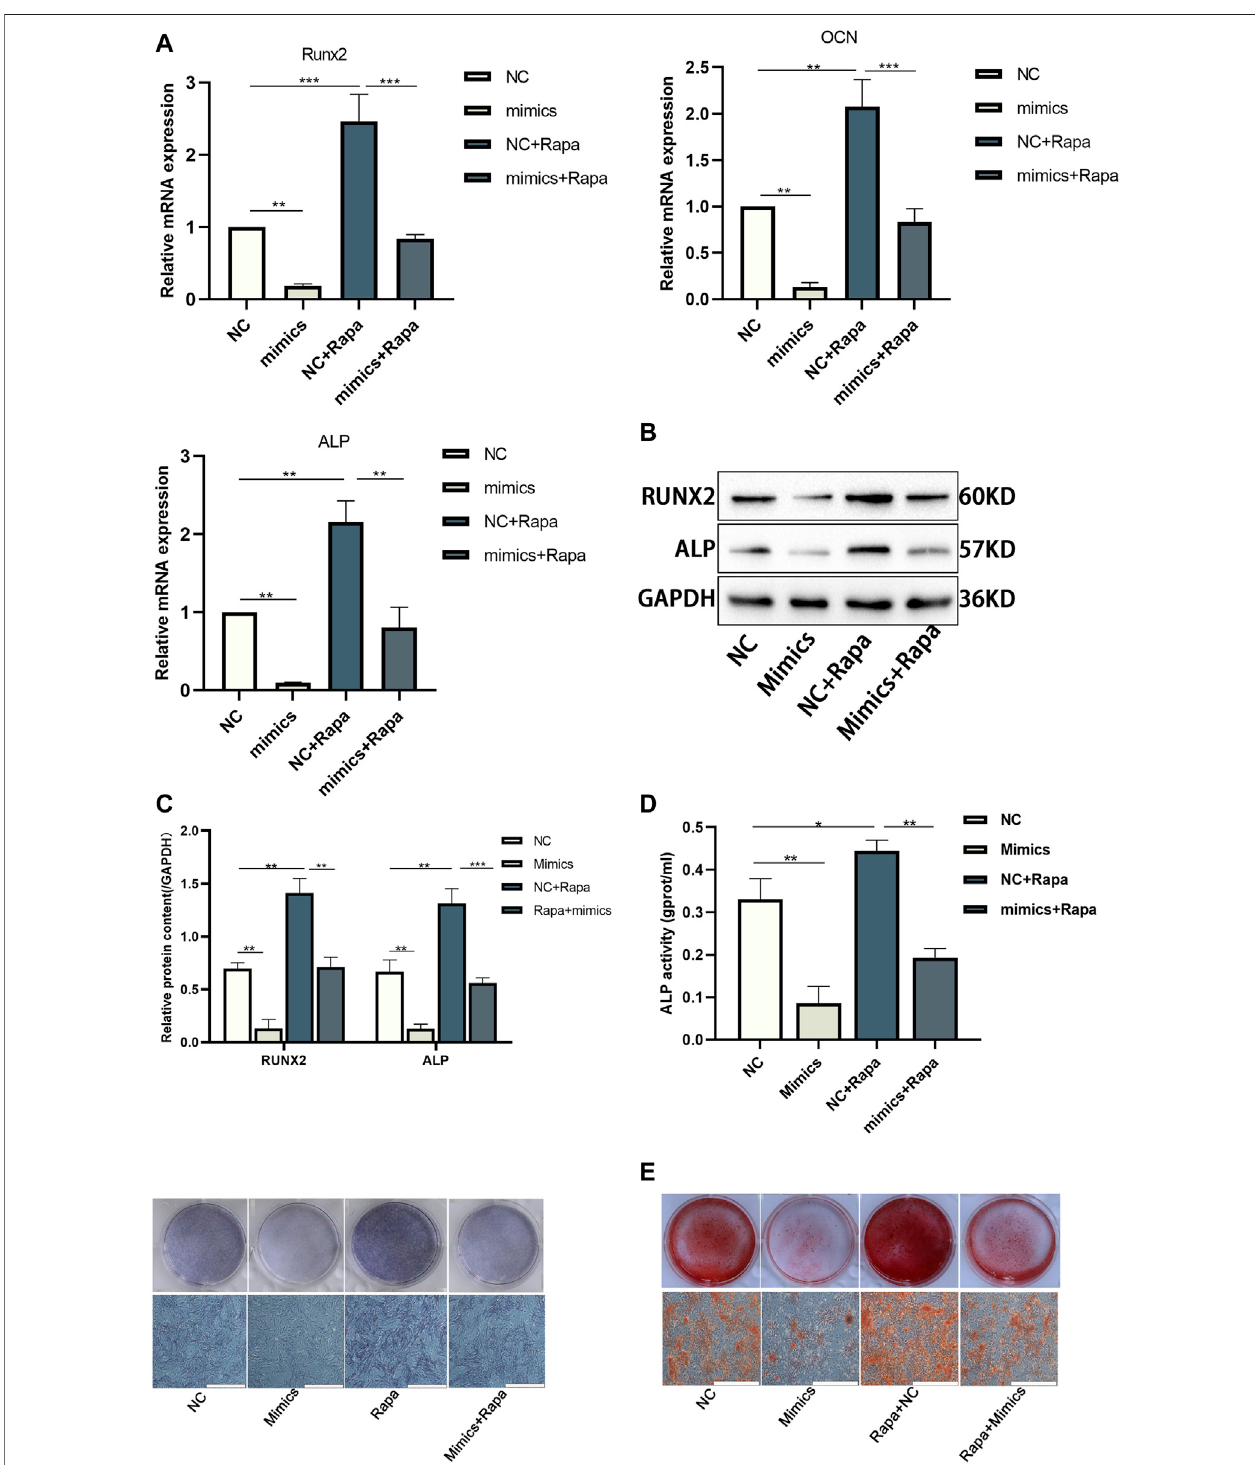
FIGURE 7 | The osteogenic differentiation elevated by Rapa was further disturbed by transfecting miR-452-3p mimics in BMSCs treated with CHNQD-00603. BMSCs treated with CHNQD-00603 were divided into four subgroups: NC, mimics, NC + Rapa, and mimics + Rapa. (A – C) Osteogenesis-related genes and proteins were detected by qRT-PCR and Western blot and protein quanti fi cation on day 7. (D) ALP activity assay and ALP staining were applied to evaluate the early osteogenic differentiation (scale bar (cid:1) 200 µm). (E) ARSwasused toestimate calcium salt deposits (scale bar (cid:1) 200 µm).Quantitative dataarepresentedasthemean ± SD(n (cid:1) 3) (* p < 0.05, ** p < 0.01, *** p < 0.0001).